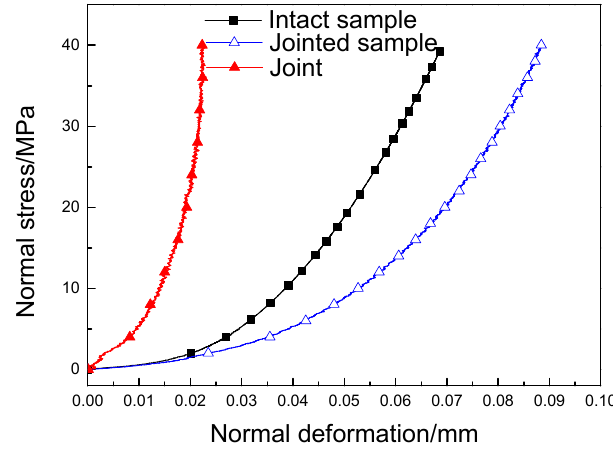
Figure 3. The curve of normal stress-normal deformation of sample in intact state and in split sate, and joint. The normal deformation of the joint δ n was calculated by the normal deformation of jointed sample minus that of intact sample.